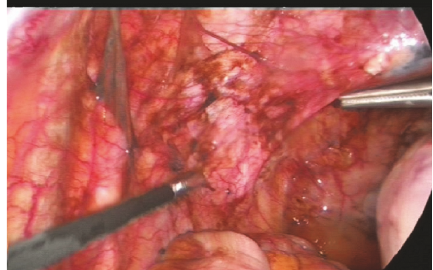
Figure 1: Intraoperative images of widespread endometriotic deposits , suggestive of leaking endometrioma.